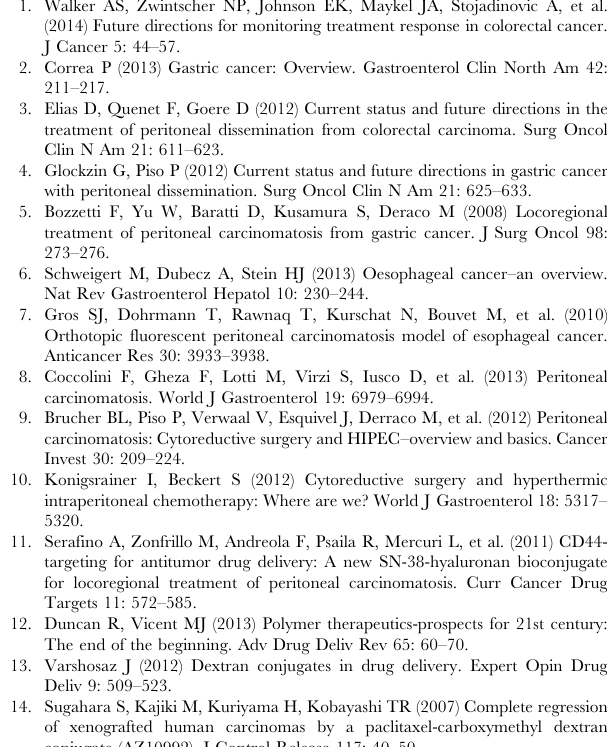
Figure S5 Impact of differential CD44 expression on bioconjugate cytotoxic activity. The parental (HCT-15) and the selected CD44 l u w (HCT-15 CD44 l u w ) and CD44 high (HCT-15 CD44 high ) HCT-15 colorectal cell lines were incubated with escalating doses of paclitaxel (upper left panel), ONCOFID-P (upper right panel), SN-38 (lower left panel) and ONCOFID-S (lower right panel). The resulting growth inhibition was evaluated by ATPlite assay. Figure shows mean 6 SD of three independent experiments. Extrapolated IC 50 values are reported in pg/mL in free drug equivalents. Table S1 IC 50 values of free and HA-conjugated drugs. The values of the reported IC 50 are the mean 6 SE of five viability experiments carried out for each tumor cell line. For each experiment, the IC 50 was calculated from each single semi- logarithmic dose-response curve by linear interpolation, and obtained values were then averaged. Values are reported in ng/ mL and for each bioconjugate they are expressed in terms of free drug equivalents. No significant difference is evidenced between the activities of HA-bound and free drugs (Mann-Whitney Rank Sum Test). Table S2 Median survival of tumor-bearing mice treat- ed with free and conjugated